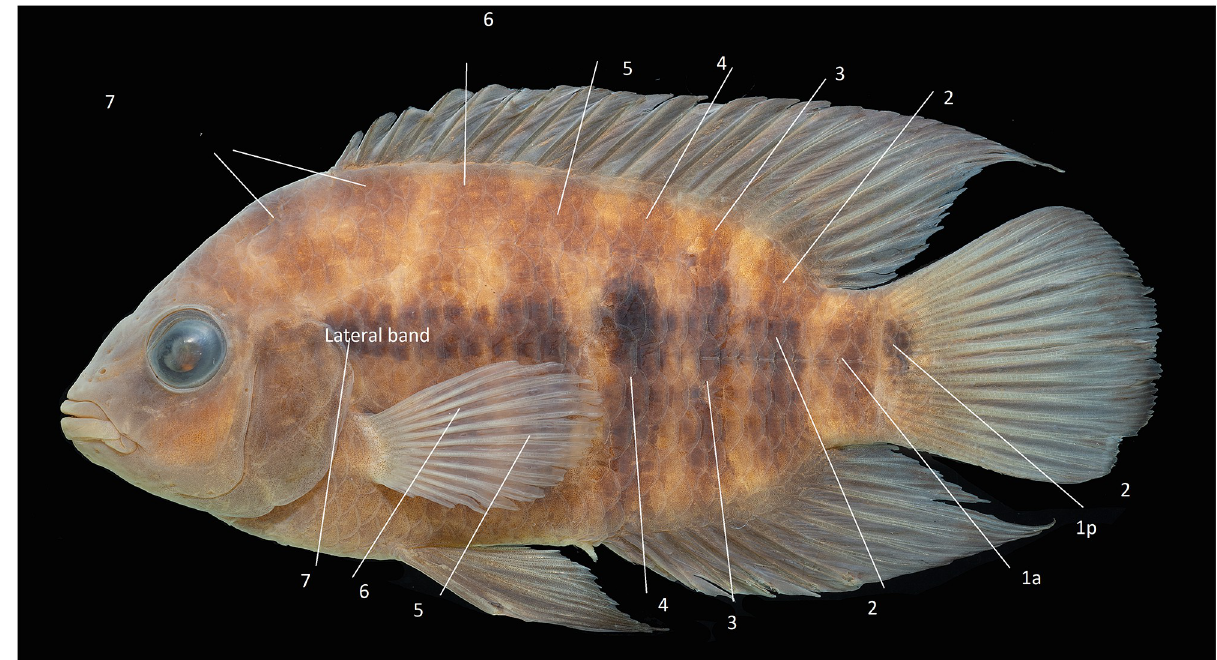
Fig 2. Map of numbering of vertical dark lateral bars in in Australoheros